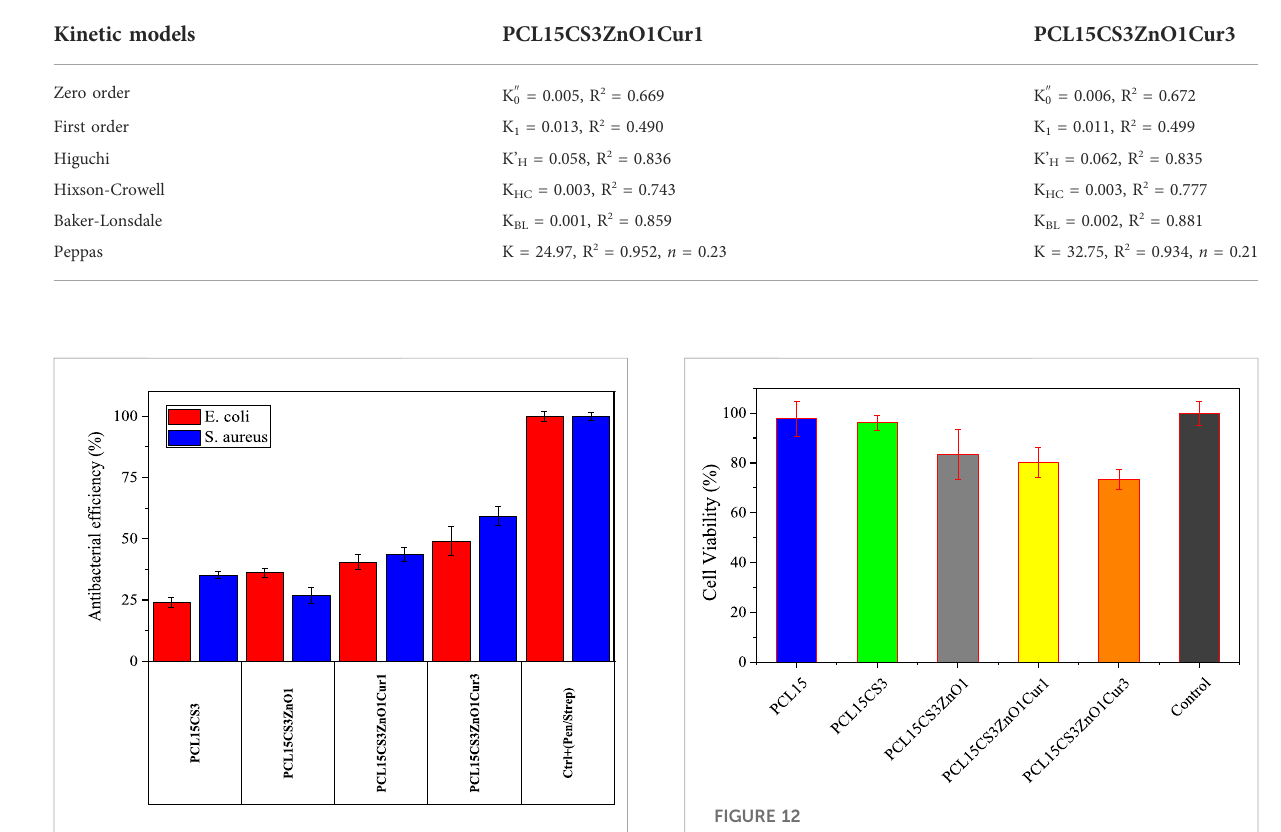
FIGURE 11 Antibacterial ef fi ciency of the electrospun samples against E. coli and S. aureus bacteria after 24 h.